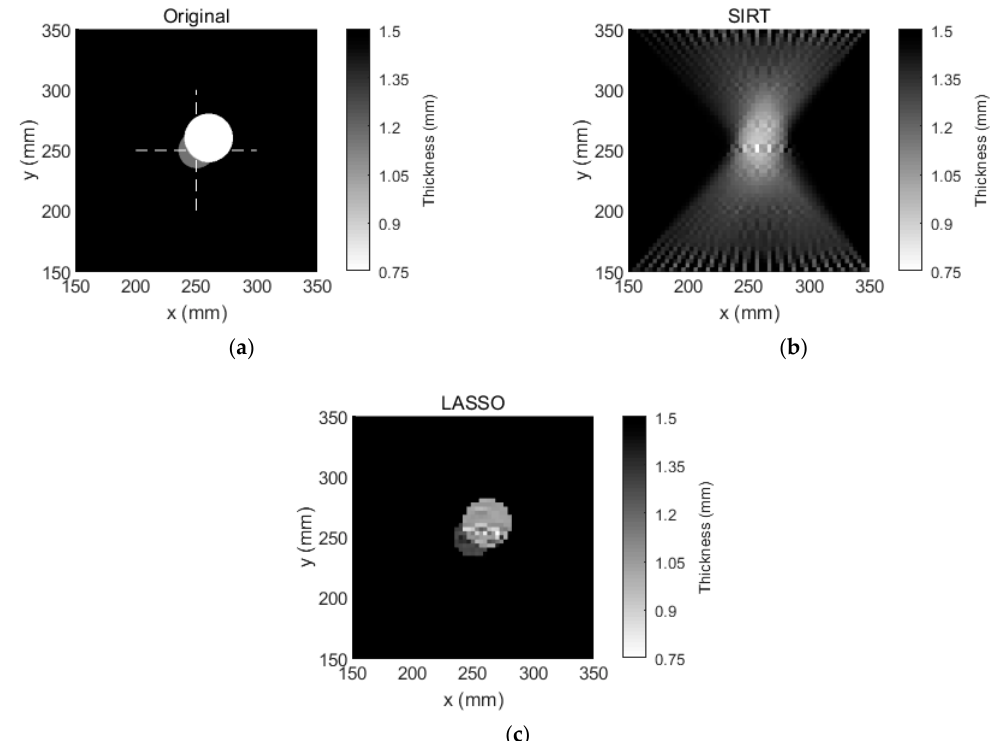
Figure 11. Tomographic reconstruction images for a 1.5 mm thick aluminum plate with two eccentric circular flat-bottomed holes, which have a common area. One of the holes, whose thickness loss was 30% and diameter was 30 mm, was in the center of the plate. The center coordinate of another hole was x = 260 mm, y = 260 mm, whose thickness loss was 50% and diameter was 40 mm. ( a ) The actual locations and sizes of the flaws. ( b ) The tomographic reconstruction image using the SIRT. ( c ) The tomographic reconstruction image using our method.